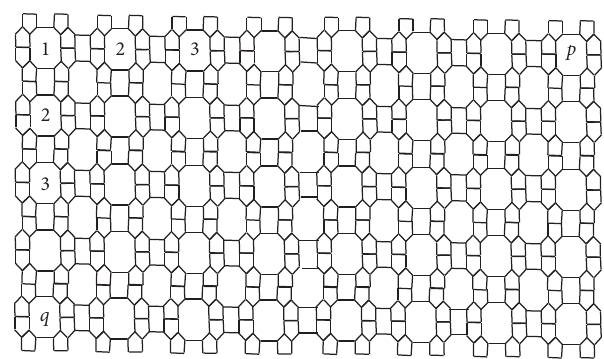
Figure 1: ( p, q ) form of graph of